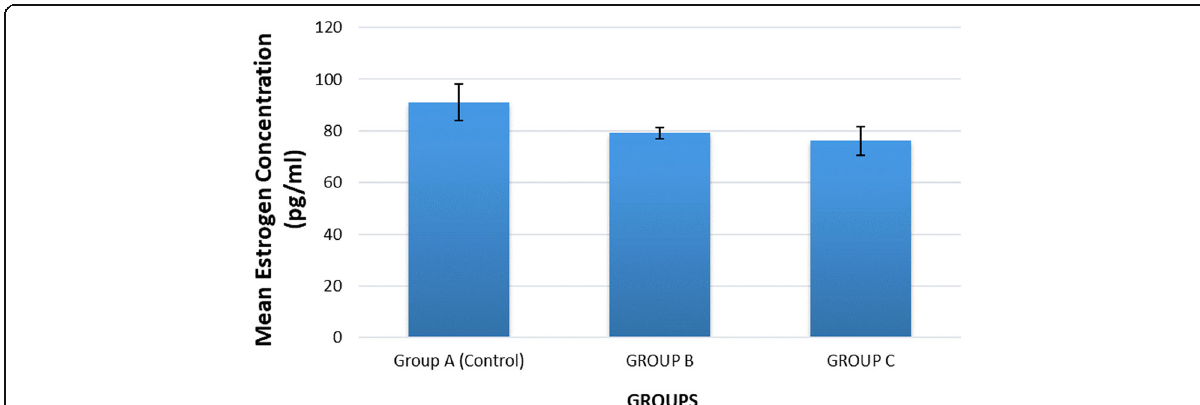
Fig. 2 Effect of perinatal β -cyp exposure on serum estrogen concentration of female F1 generation rats at sexual maturity. Results are given as mean ± SEM for 5 rats in each group. Experimental groups are compared with group A (control). No significant difference at a 95% confidence interval ( p > 0.05). Groups A, B, and C represent the control (given 0.5 ml olive oil), 15 mg/kg β -cyp-treated rats, and 30 mg/kg β -cyp-treated rats, respectively